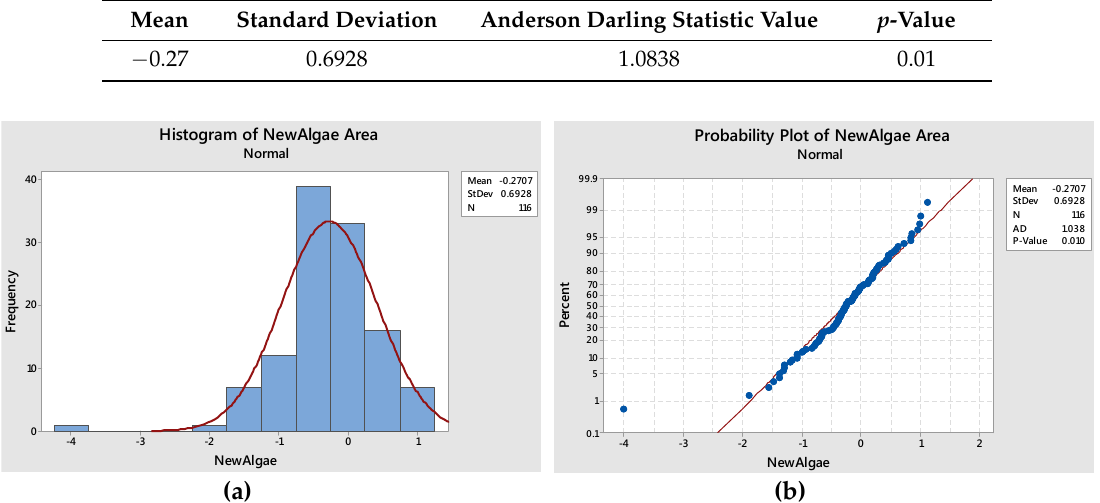
Table 5. Statistics of new Algae Area.